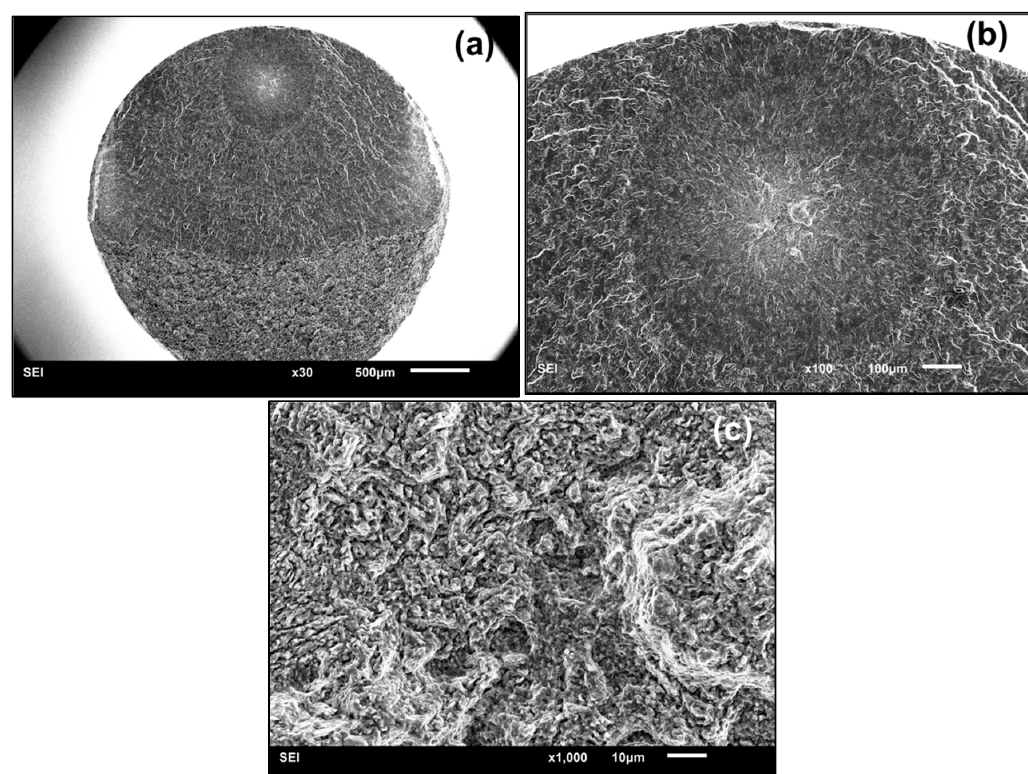
Figure 4. Typical fractography of single-point interior crack initiation without facet feature (smooth specimen, R = − 1, a = 510 MPa, N f = 9.0692 × 10 8 cycles); ( a ) the whole fracture surface; ( b ) enlargement